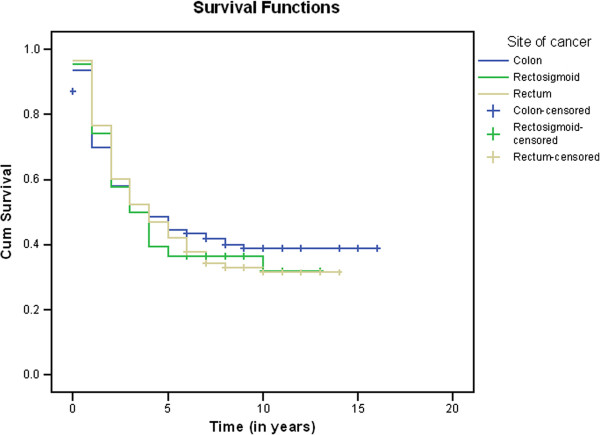
Kaplan-Meier Curves for Colon, Recto-sigmoid, and Rectal Cancers. Legend: The cumulative (Cum) survival for 1994–2004 for patients with colon, recto-sigmoid, and rectal cancers was 40.9, 34.8%, and 33.6%, respectively.